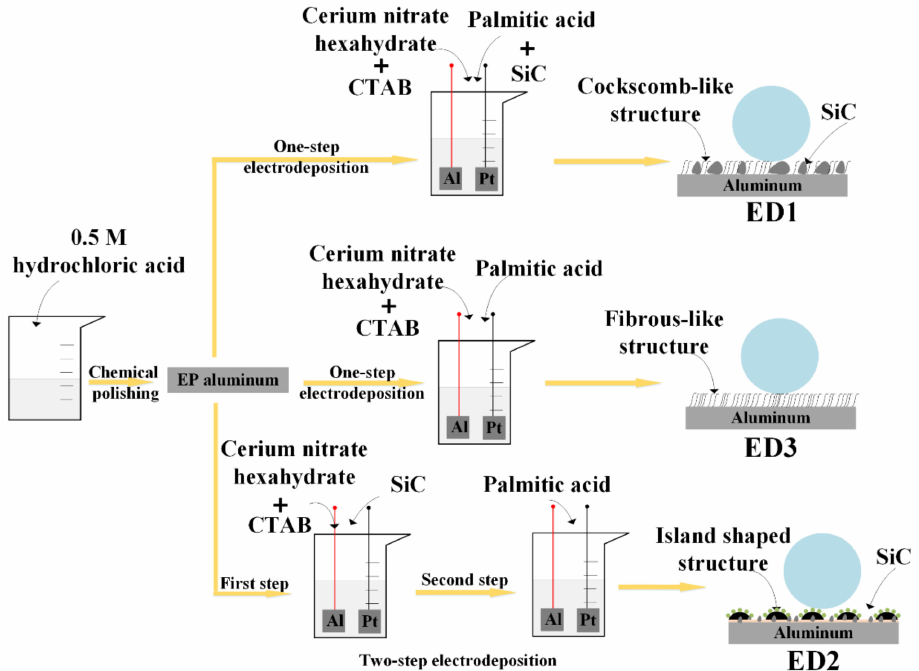
Figure 1. The schematic of the fluorine-free electrodeposition